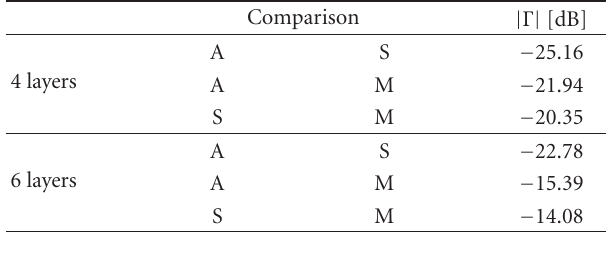
Table 2: Nominal dimensions of ID-1 card type.